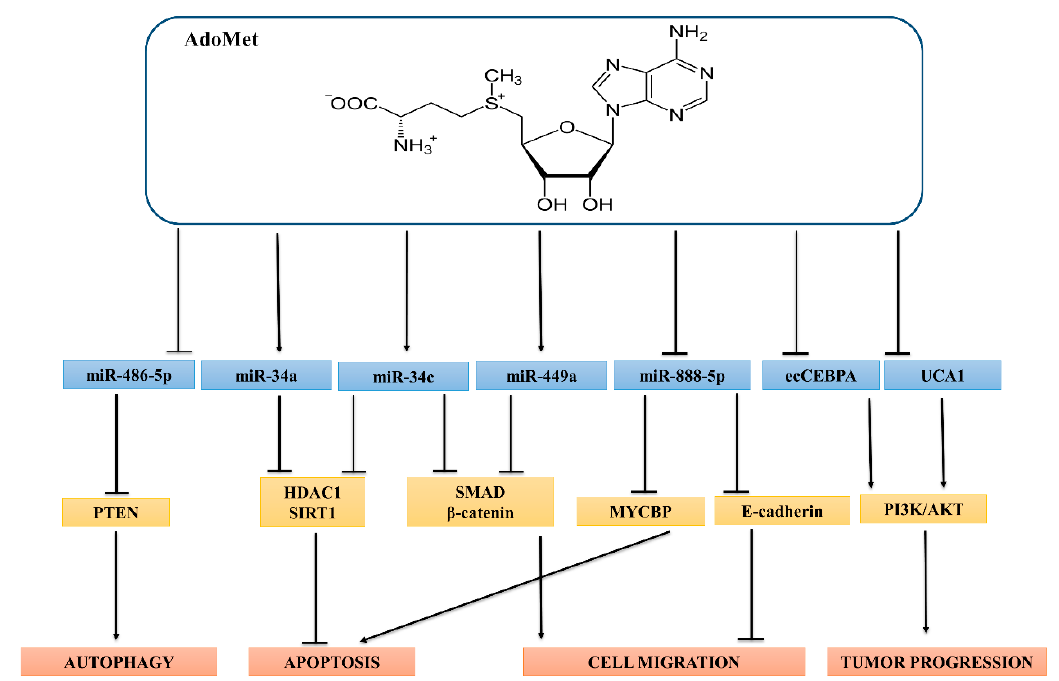
Figure 1. Regulation of ncRNAs by AdoMet. AdoMet significantly activates/inhibits multiple signaling pathways through the regulation of ncRNAs expressions in different types of human cancer. In breast cancer, AdoMet induces both autophagy and apoptosis and inhibits cell migration through the modulation of miR-486-5p, miR-34a/c, and miR-449a. In LSCC, AdoMet activates apoptosis and reduces cell migration by downregulation of miR-888-5p. In HCC, AdoMet hampers tumor progression through downregulating lncRNAs ecCEBPA and UCA1.